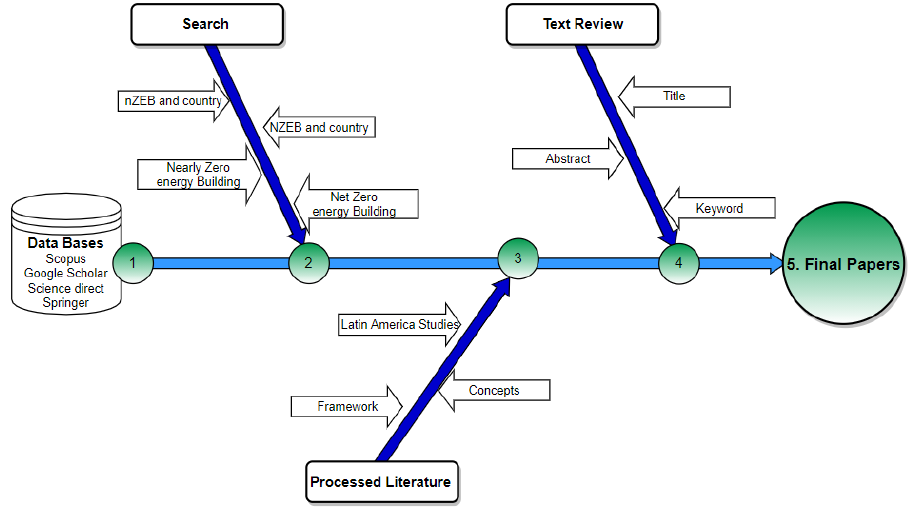
Figure 5 . Search procedure for the inspection of the literature. Figure 5. Search procedure for the inspection of the